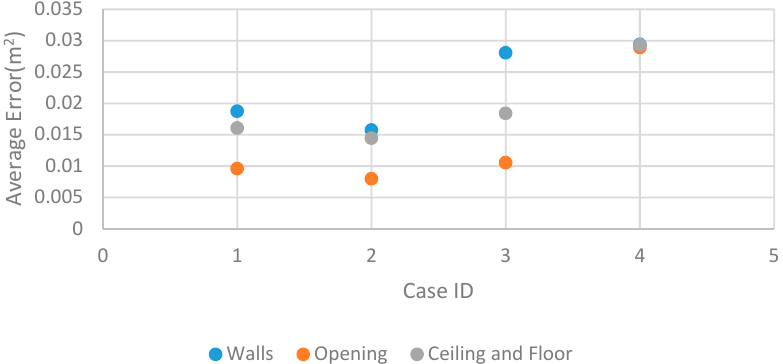
Figure 16. Average error for each component.